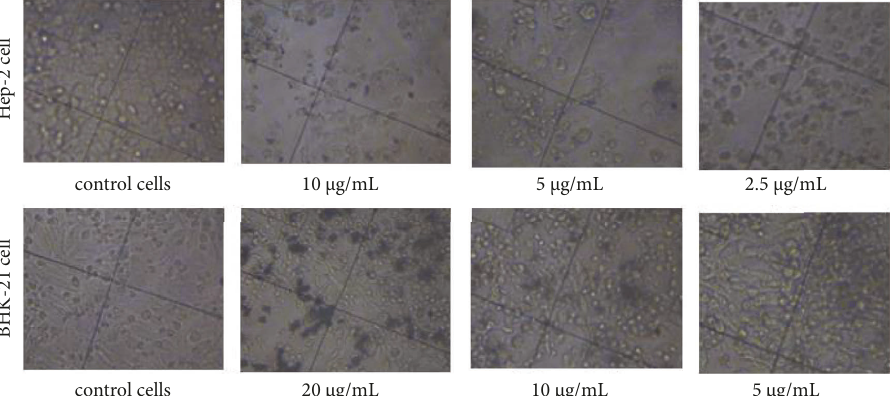
Figure 3: Morphology changes of cells before and after adding colloidal-coated silver. Inverted microscope pictures of cells in the presence of varying concentrations of Ag NPs at 72h exposure time (70 ×